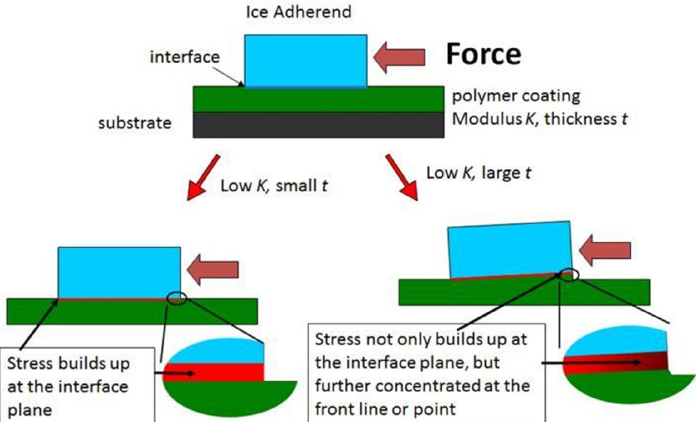
Figure 8. Effect of coating modulus ( K ) and thickness ( t ) on ice-removal through regulation of stress buildup at polymer soft coat interface. Reprinted with permission from Ref. [146]. c (cid:13) 2014 Virginia Commonwealth University.